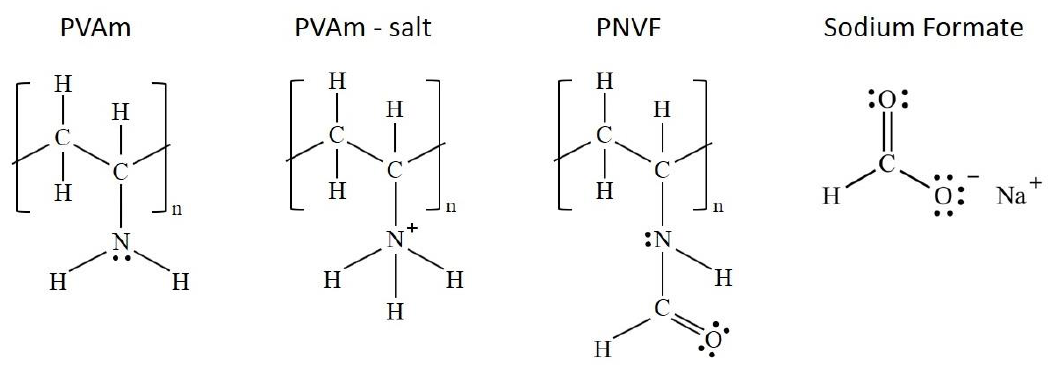
Figure 2. Components of commercial PVAm solution containing 5% molar ratio of PNVF with respect to PVAm and PVAm salt.